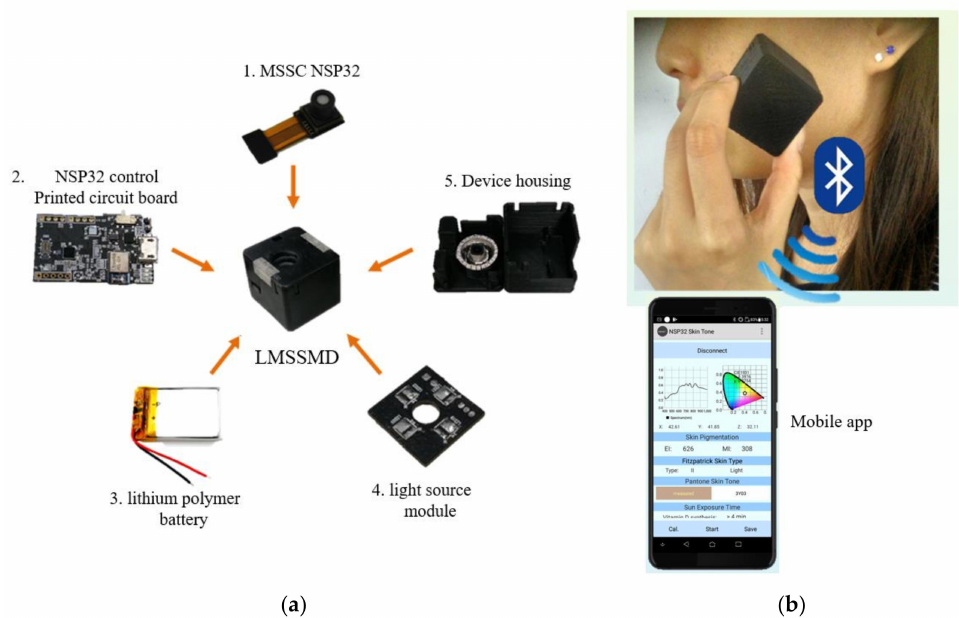
Figure 8. The LMSSMS: ( a ) LMSSMD and ( b ) usage scenarios and mobile app.